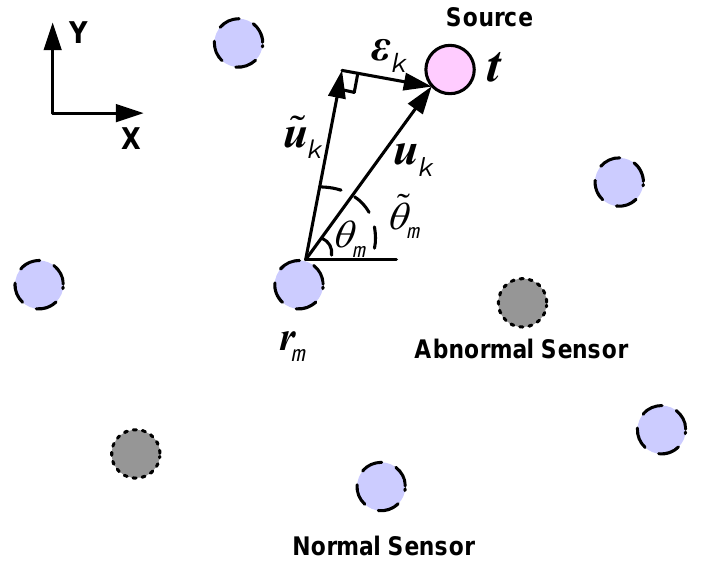
Figure 1. Illustration of the BOSL